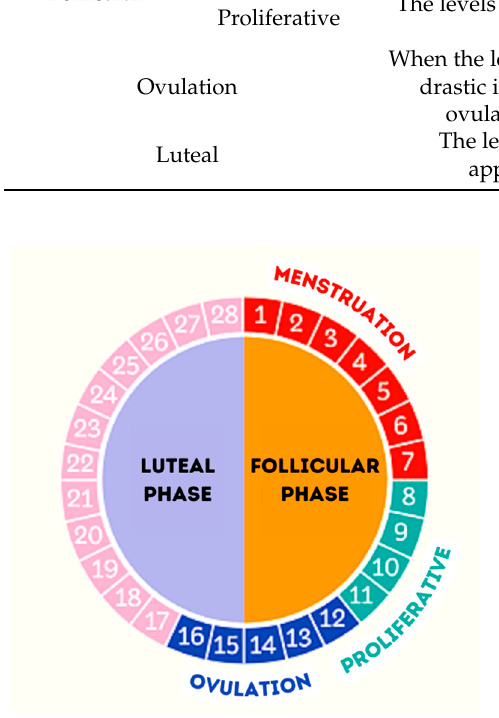
Figure 1. Phases of the MC.